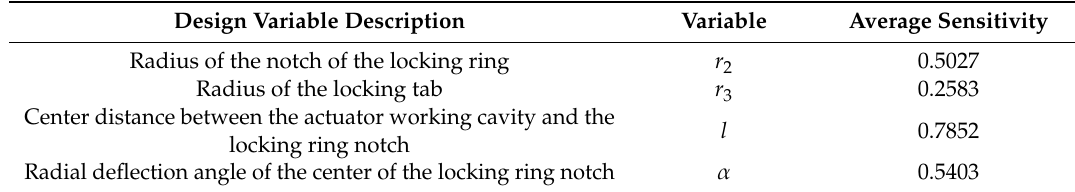
Table 4. The absolute values of the average variable sensitivities of F ml in the design space.